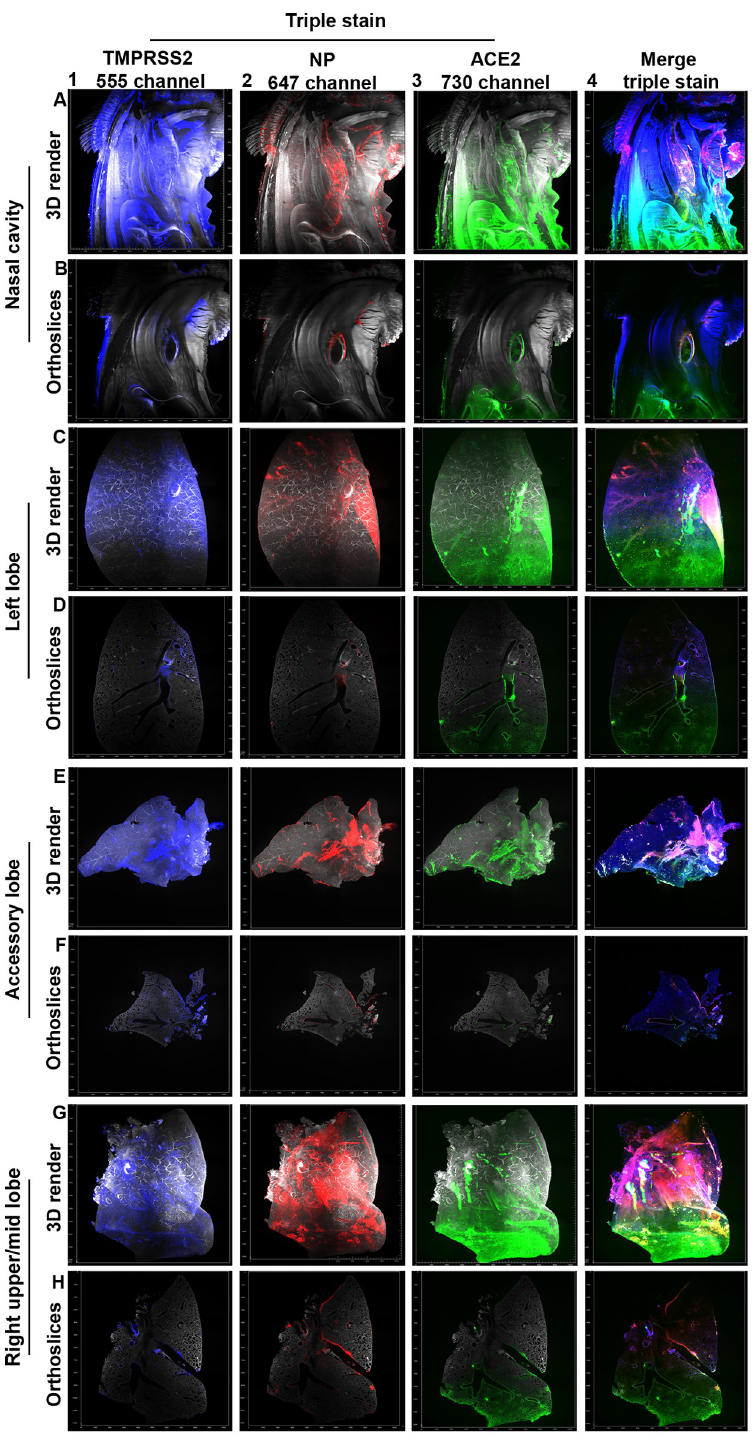
Fig 5. SARS-CoV-2 infection necessitates sufficient amounts of ACE2 and TMPRSS2 expression at 4-dpi. TMPRSS2 was imaged in the 561 channel, NP in the 647 channel, and ACE2 in the 730 channel. With fluorescence signal for the single channels shown in red (ACE2), green (NP), blue (TMPRSS2), and background in grey. (A/B) ACE2 and TMPRSS2 signals in the nasal cavity towards the nasopharynx overlaps with SARS-CoV-2 infection seen in both the 3D render and orthoslices. 0.63 zoom, voxel resolution X,Y,Z: 4.79 μ m, 4.79 μ m, 5 μ m. (C/D) In the left lobe